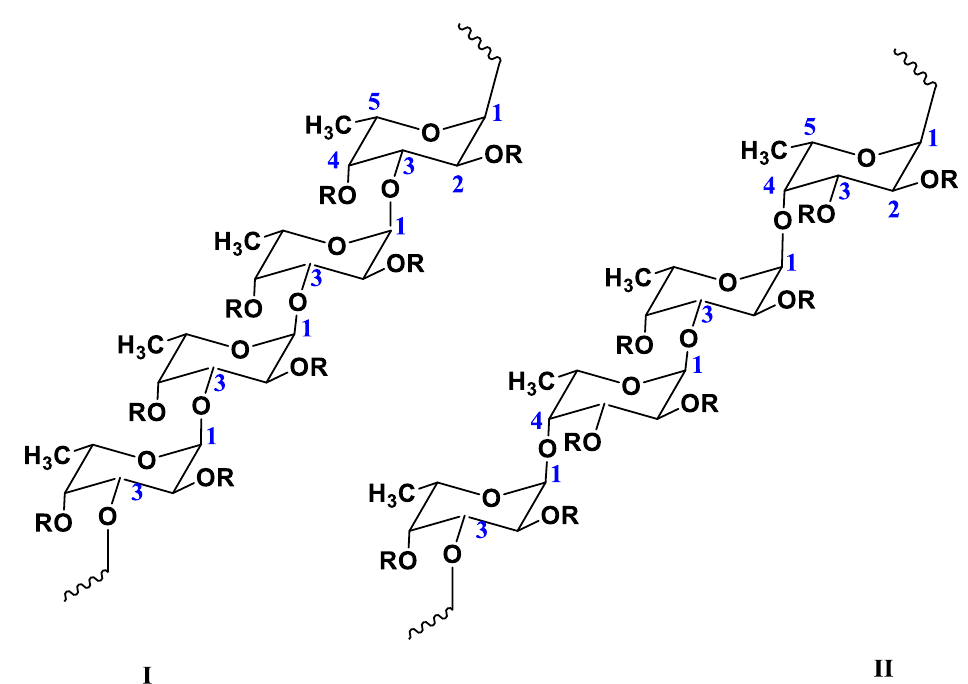
Figure 1. Two types of homofucose backbone chains in brown seaweed fucoidans. Chain ( I ) contains (1 → 3)- α -L-fucopyranose, chain ( II ) contains alternating (1 → 3)- and (1 → 4)- α -L-fucopyranose residues; R — carbohydrate substituents (sugars) or noncarbohydrate substituents (sulfate or acetate groups).